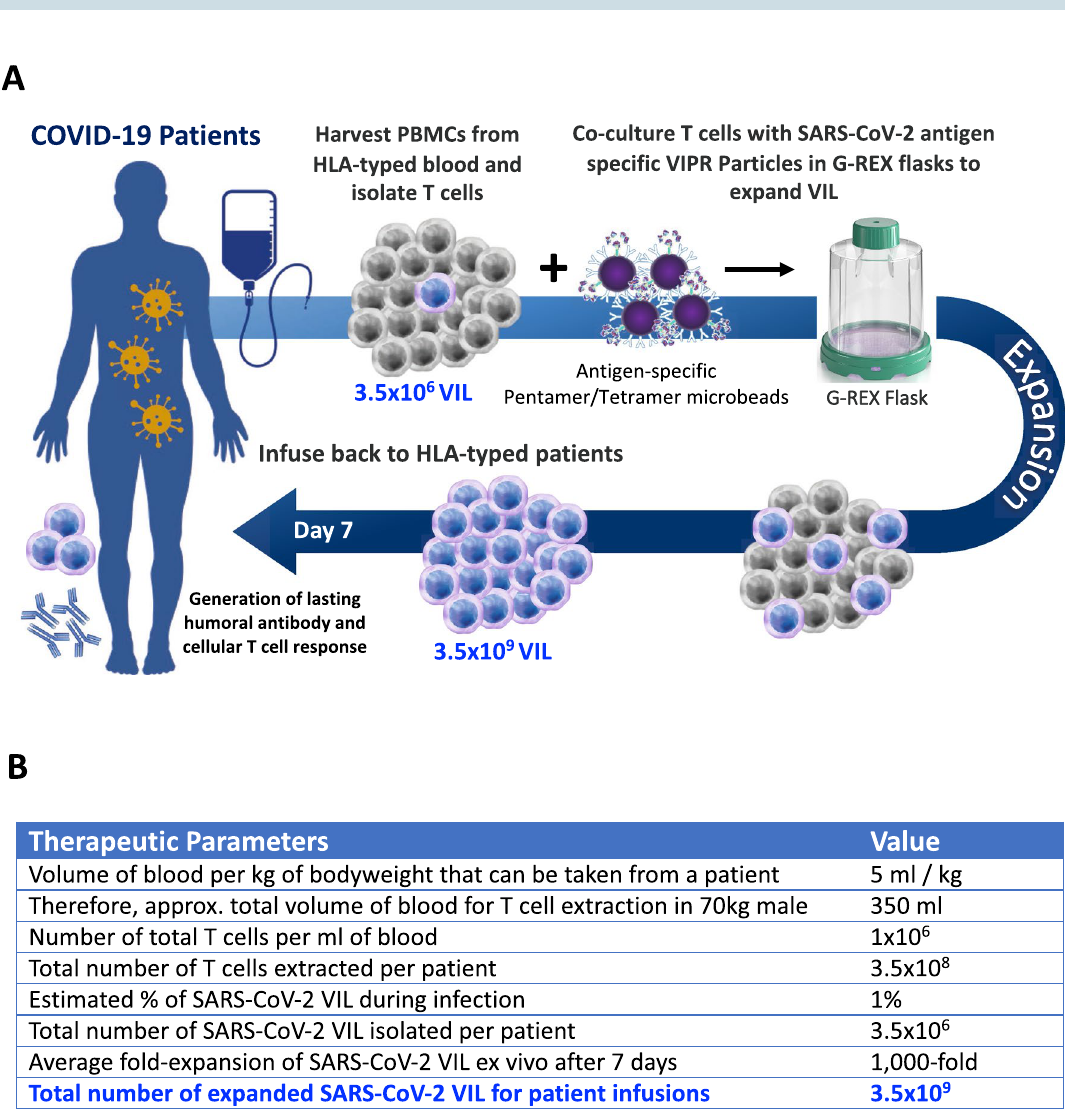
Figure 6. Allogeneic VIL Therapy Platform: An adoptive cell therapy for the treatment of individuals suffering from severe symptoms of COVID-19. ( A ) Schematic for a COVID-19 cell therapy in which PMBCs are collected from the blood of HLA-typed hospitalized patients and total T cells isolated. T cells are stimulated with HLA- matched MHC-I/MHC-II antigen-specific SARS-CoV-2 VIPR beads to enrich and expand CD4 + and CD8 + T cells with TCRs specific for the SARS-CoV-2 antigen epitopes. These antigen-specific VIL expand at an average of 1000-fold prior to adoptive transfer back to HLA-matched patients to mediate a T cell immune response to support the eradication of the SARS-CoV-2 virus and to engender protective immunity against repeat infection. ( B ) Estimations of viral-specific T cell numbers generated ex vivo for patient infusion based on the empirical data of VIL expansion by VIPR